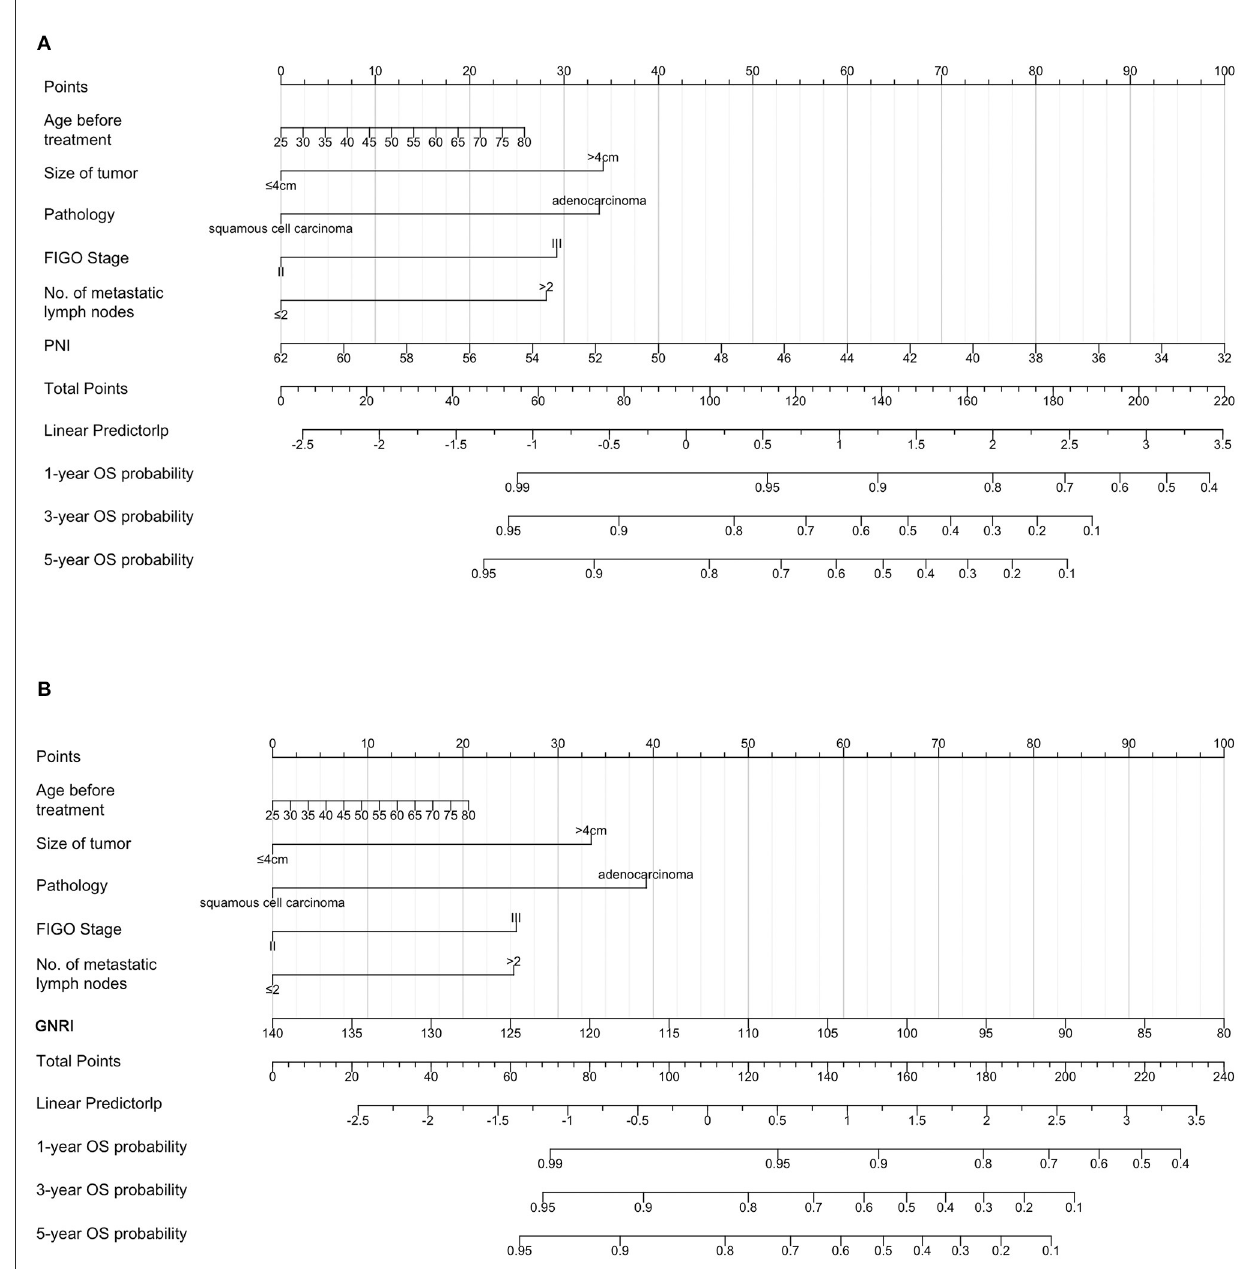
FIGURE7 Prognostic nomograms for overall survival prediction according to the prognostic nutritional index (PNI) (A) and geriatric nutritional risk index (GNRI) (B) . Points were assigned for age before treatment, and for tumor size, histological type, stage, number of metastatic lymph nodes, and nutritional indicators. The score of each predictor was determined by drawing a vertical line from the value to the score scale. The total score was summed up by the scores of these predictors, which correspond to overall survival rate.